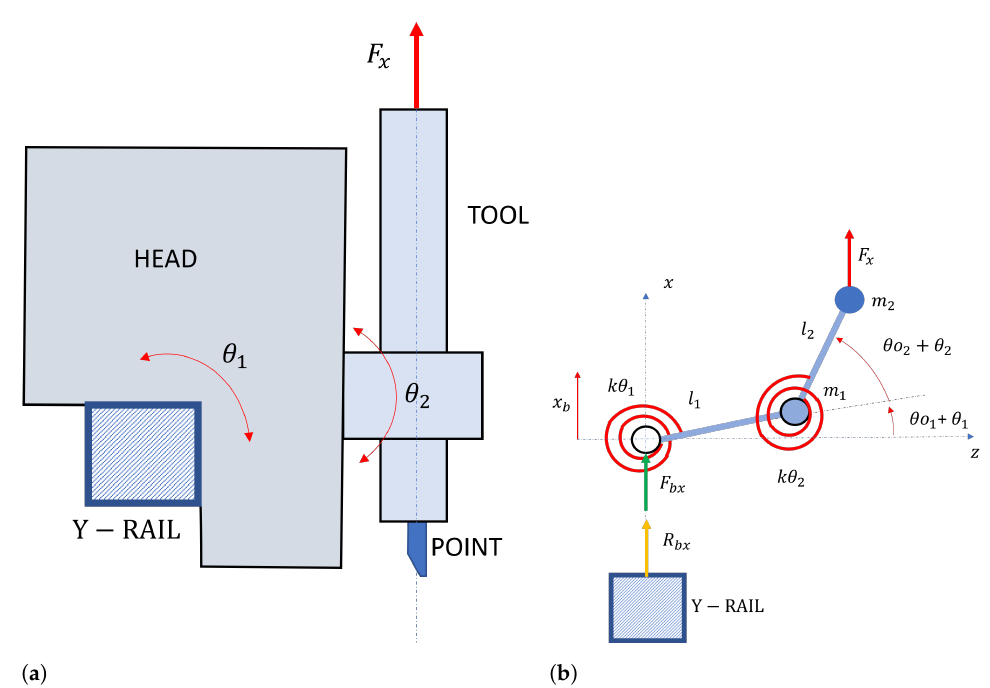
Figure 3. ( a ) Physical scheme of the cutting head on the Y-rail; ( b ) gray-box model of the cutting